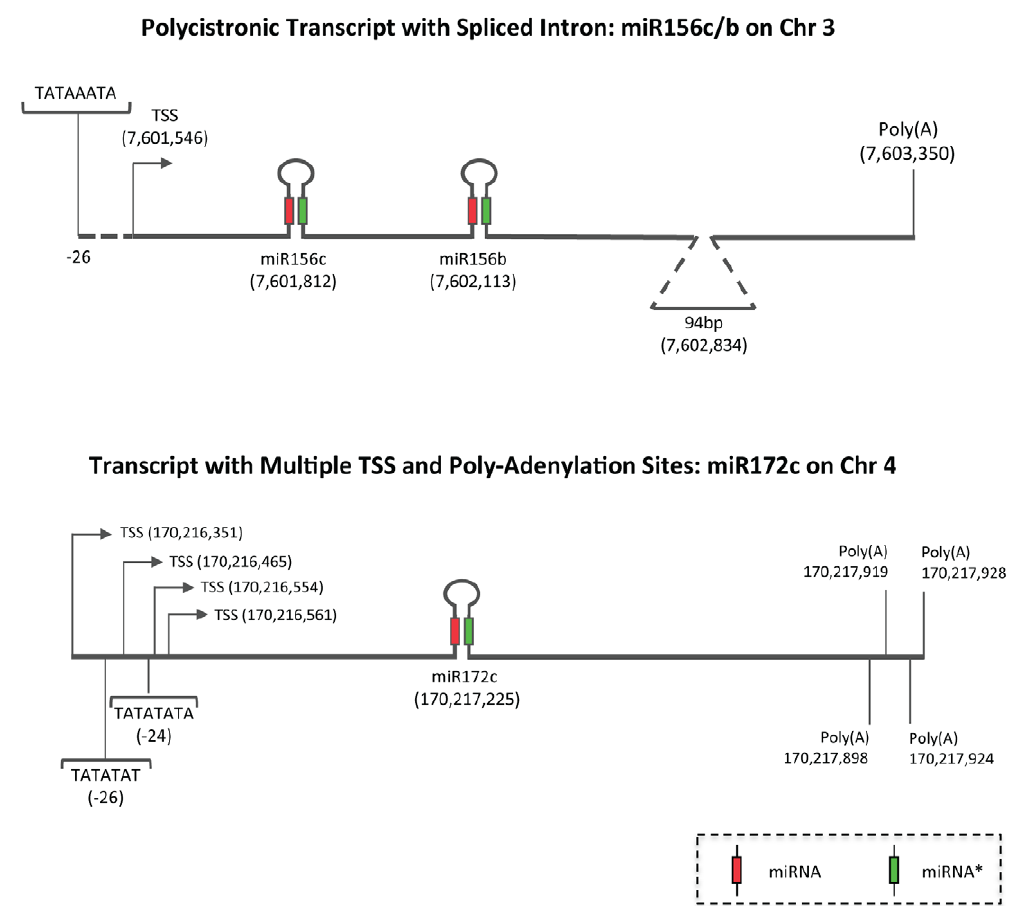
Figure 3. Schematic representation of splicing variants for maize miRNA primary transcripts. Examples of introns, alternative transcriptional start sites (TSSs), polyadenylation sites, and polycistronic features of pri-miRNAs seen in miRNA RACE amplicons mapped to the maize genome. Mature miRNAs are represented by red boxes, miRNA* by green boxes. miRNA precursors are represented by hairpin structures while TATA box-like motifs are also indicated in the figure. Numbers in parentheses indicate physical locations on the reference chromosome. (A) RACE products show that miRNAs pri-miR156b and pri-miR156c are transcribed as a single transcript, with a 94nt intron spliced out from the locus. (B) pri-miR172c is an example of a miRNA having multiple TSSs and polyadenylation sites. 5 9 RACE products map to 4 distinct locations and 3 9 RACE products carry 4 distinct polyadenylation signatures. Two of the TSSs are associated with TATA box-like motifs.